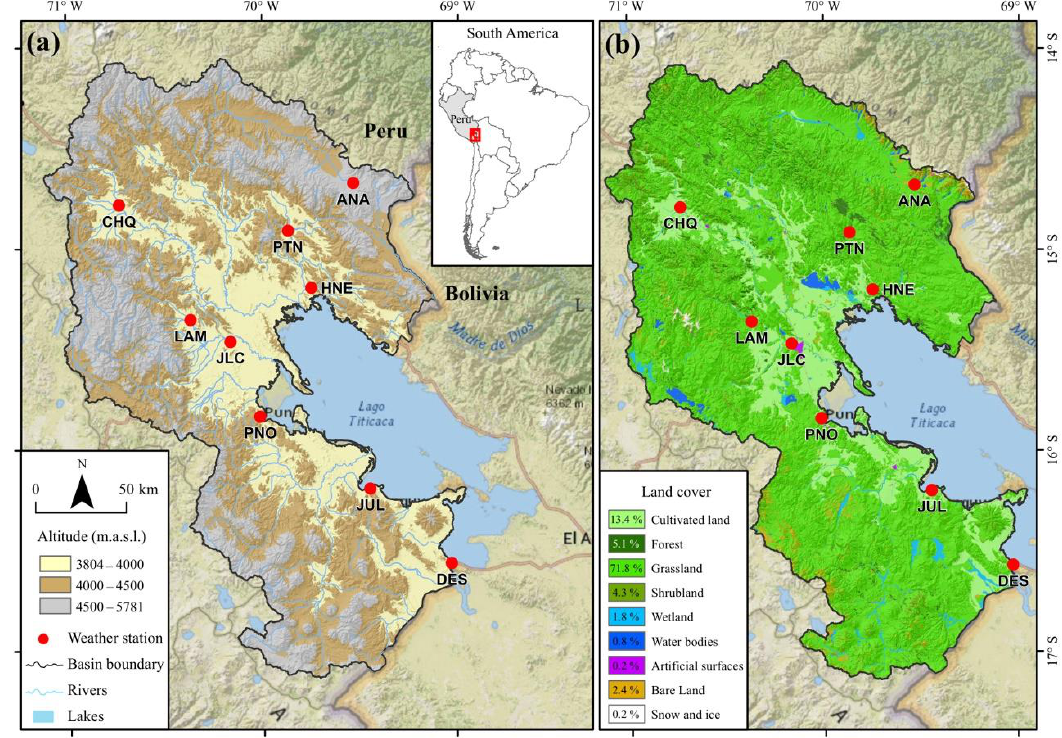
Figure 1. ( a ) Location of the study area and spatial distribution of weather stations and ( b ) land